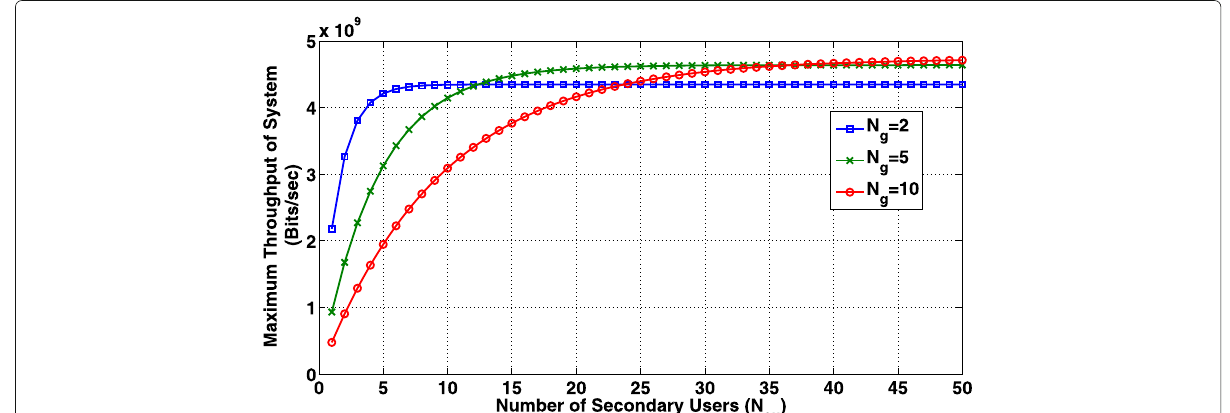
Fig. 13 Maximum throughput of the system in parallel sensing scheme versus number of secondary users when N g = 2, 5, and 10